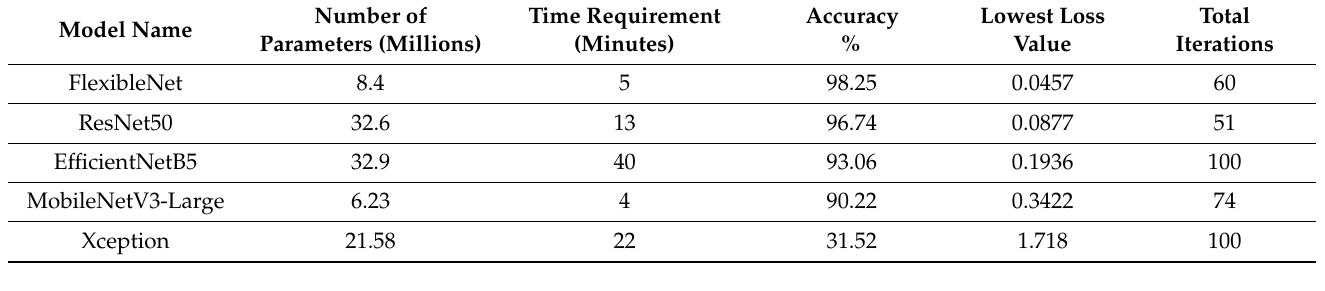
Table 5. Summary of the outcomes of the experiments using an image resolution of 64 × 64.